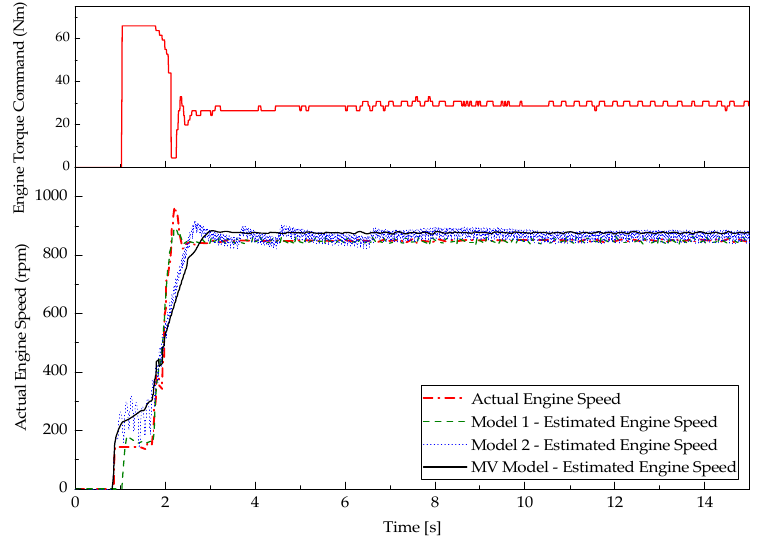
Figure 12. Validation results of three powertrain models with respect to the first cranking experiment. Figure 13. Validation results of three powertrain models with respect to the second cranking experiment.